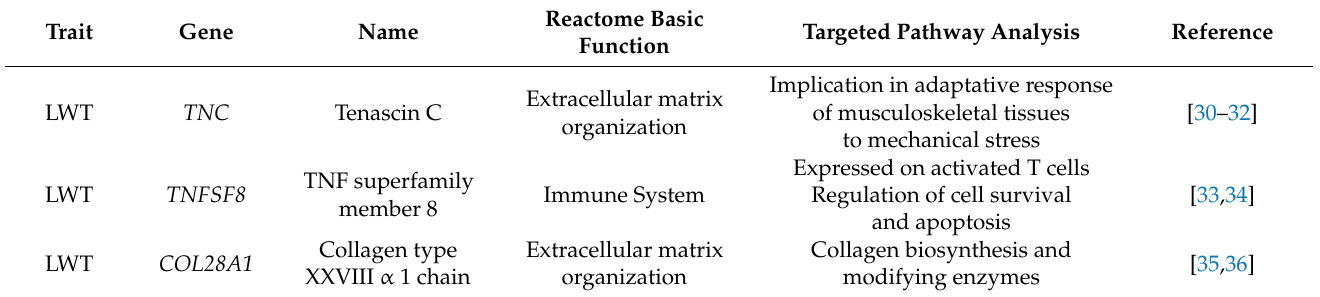
Table 4. Trait, gene and gene name, results of the pathway analysis with the Reactome basic function and the targeted pathway analysis, and references from the literature regarding each gene associated with ewe lamb live weight (LWT) at eight months of